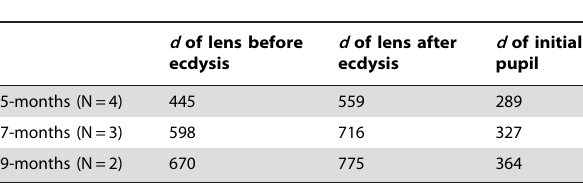
Table 2. Lens and pupil diameters of the AM